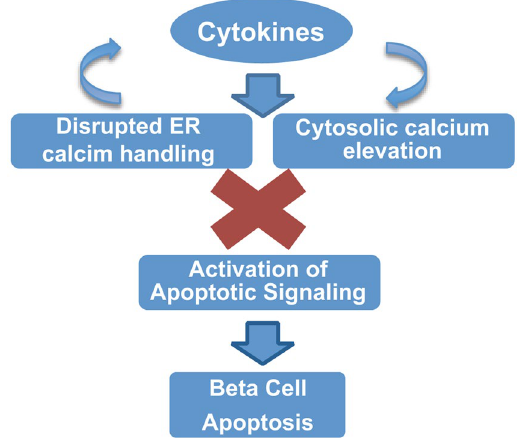
Figure 8. Cytokines Lead to Altered Cellular Calcium Homeostasis, and Induction of Β eta Cell Death. In